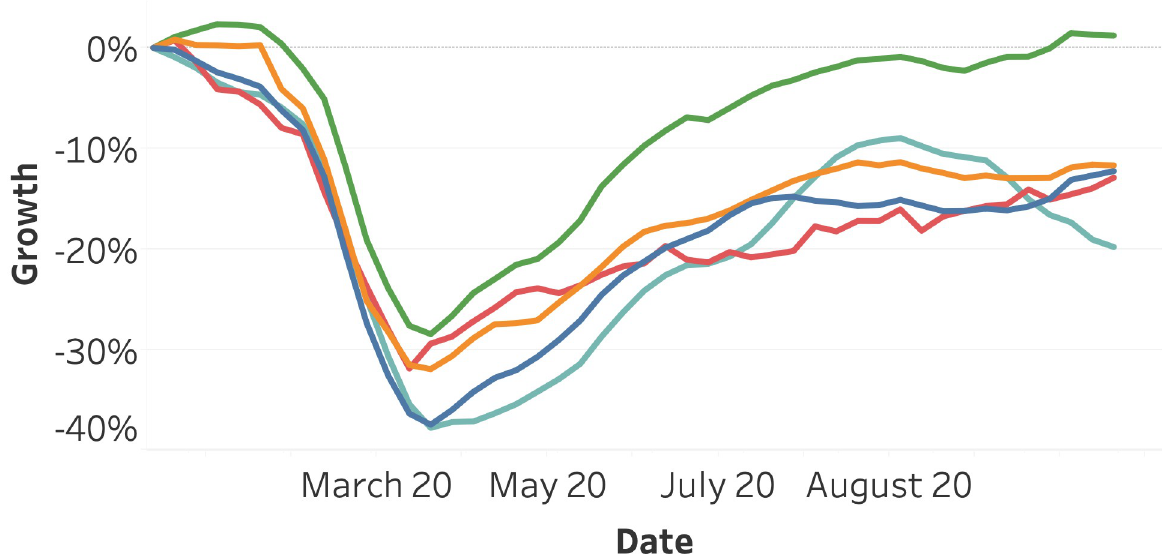
Fig 6. Average stock indices growth as of January 2020, split per continent. Africa (dark blue), America (orange), Asia (red), Europe (light blue), and Oceania (Green).